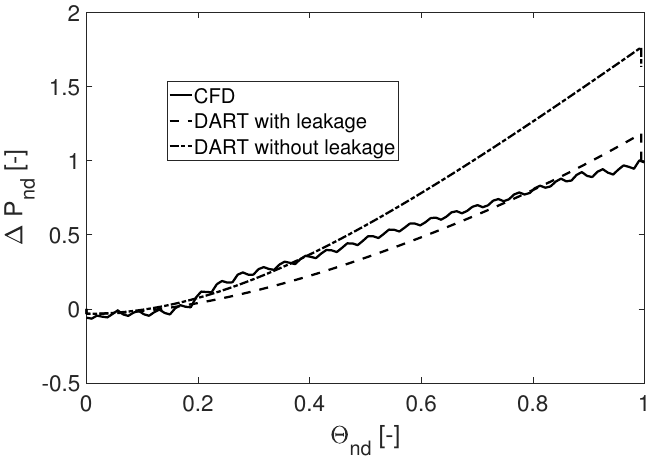
Figure 9. Comparison of pressure rise between DART (with and w/o leakage option) and CFD